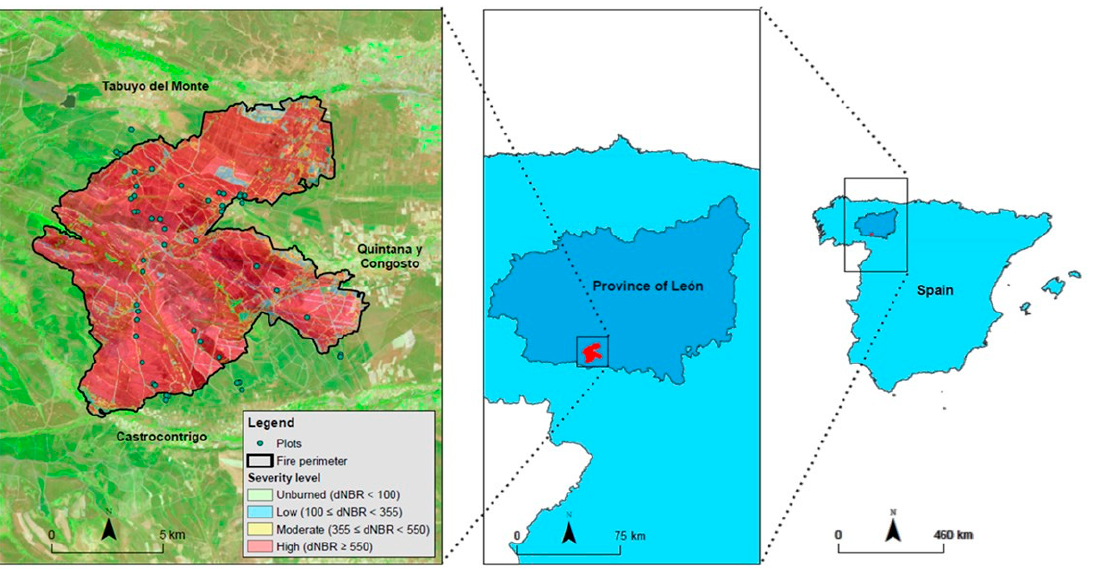
Figure 1. Location of the study area in Sierra de Teleno (León, NW Spain). Table 1. Soil characteristics of the unburned situation from 2012 wildfire.